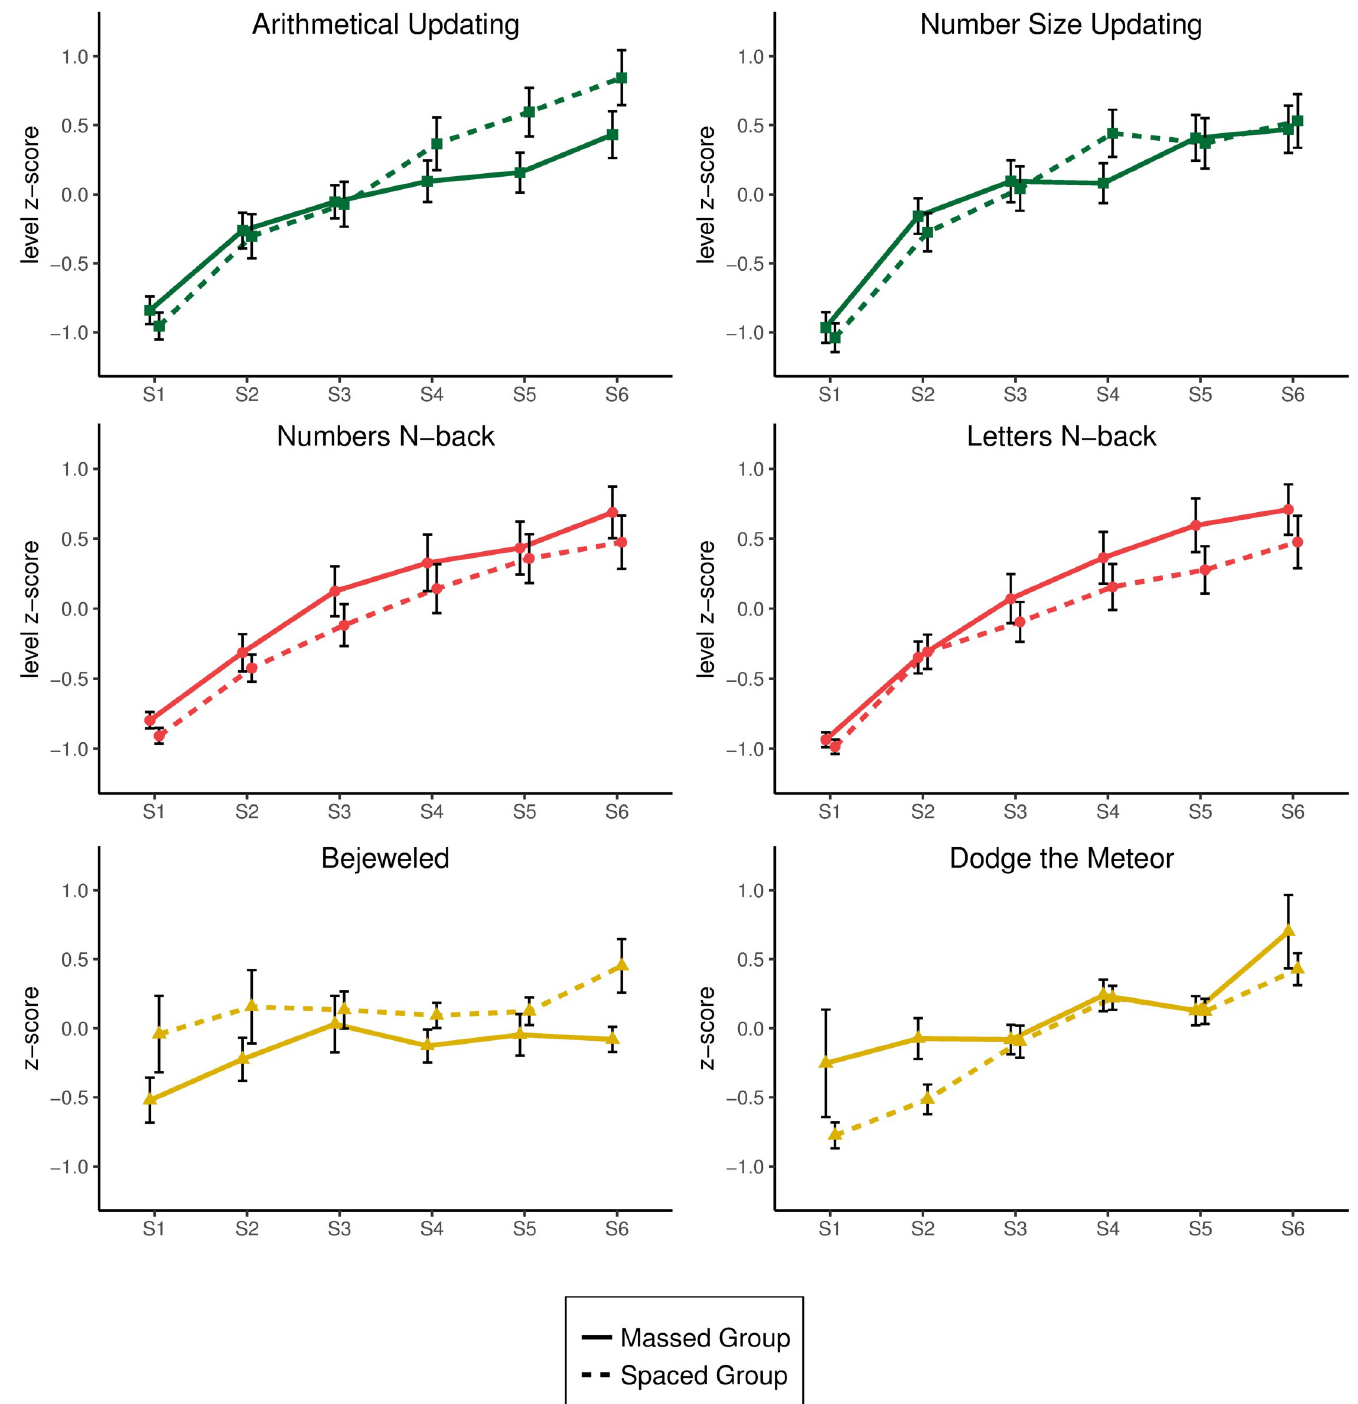
Fig 2. Mean level reached in all tasks across the six training sessions for the arithmetical, n -back, and active control groups. The bars represent two standard errors of the mean.